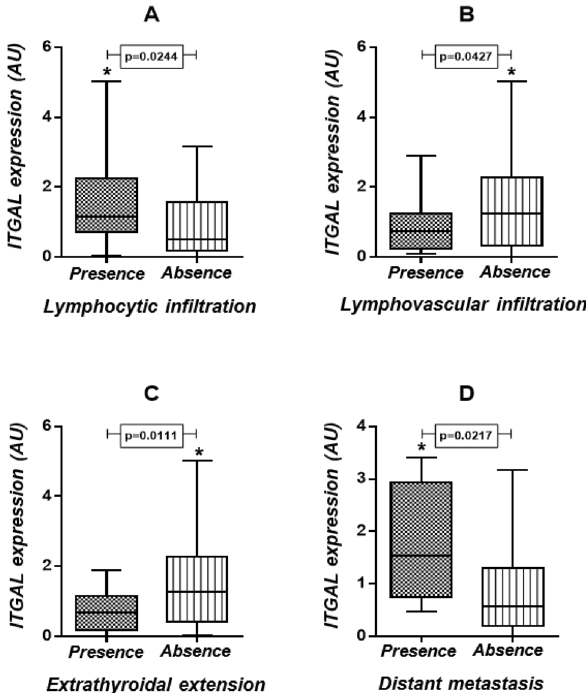
Figure 2. ITGAL mRNA expression correlations with clinical features. ( A ) Lymphocytic infiltration; ( B ) lymphovascular infiltration; ( C ) extrathyroidal extension and ( D ) distant metastasis at diagnosis. Mann– Whitney